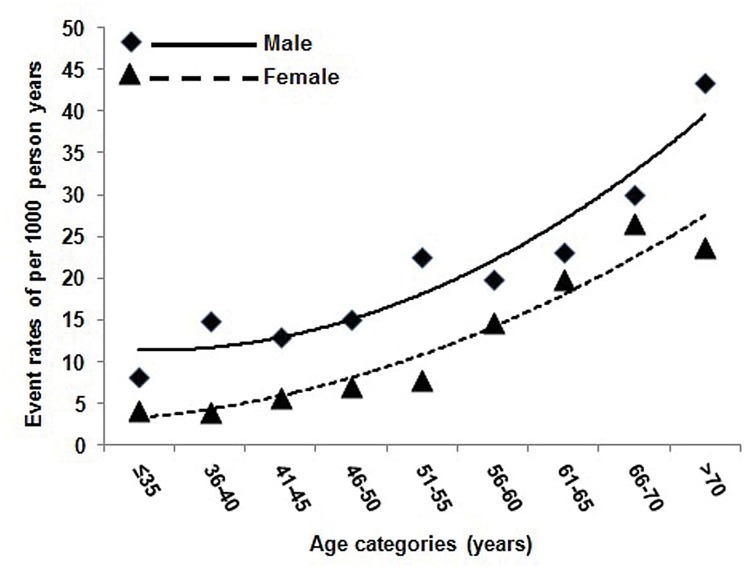
ACS incidence per 1000 person-years among men and women with in different age categories.ACS incidence generally increased with age among (A) 876 men and (B) 1259 women. Descriptive analyses are displayed with best-fit curves defined by the polynomial equations (A) y = 0.4568x2 -1.0512x +11.96 (R2 = 0.9074) and (B) y = 0.2867x2 + 0.1611x + 2.8626 (R2 = 0.9261).